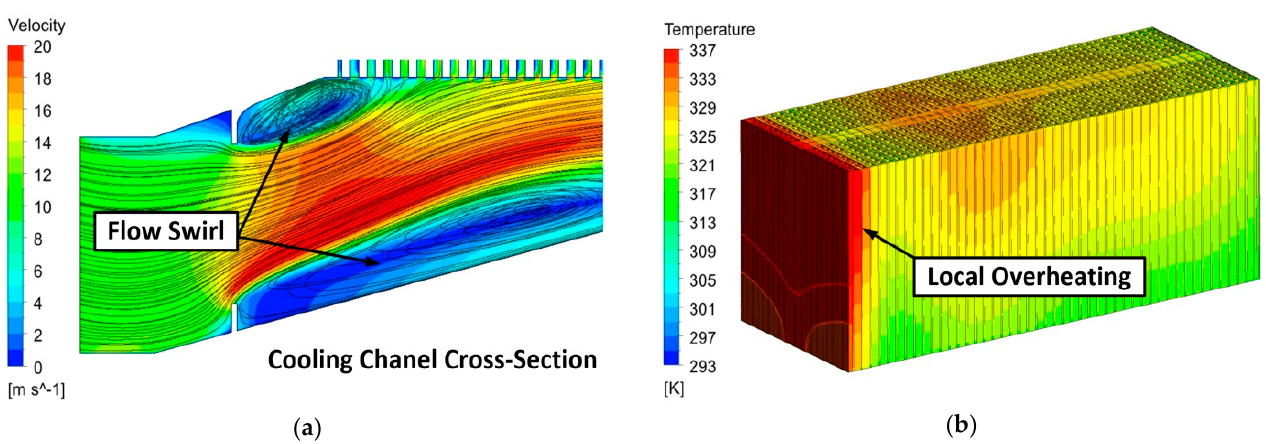
Figure 13. ( a ) Streamlines of the air coolant and ( b ) temperature distribution at P el = 1000 W of load.